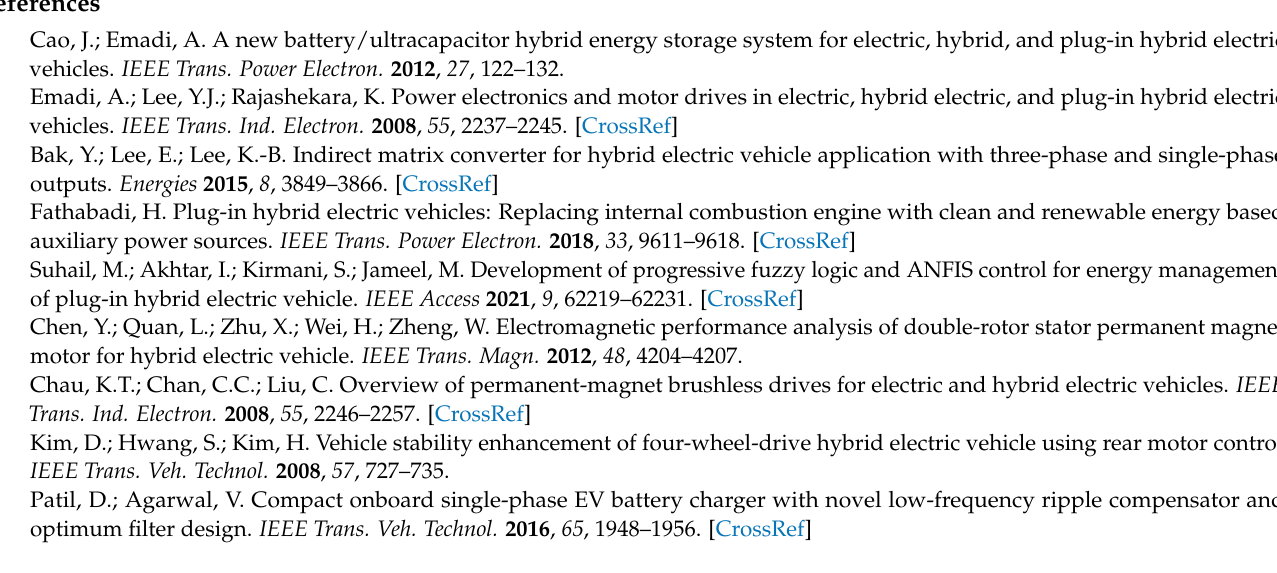
Figure 16. Experimental results of output voltage control of integrated OBC when the load impedance is abruptly changed ( a ) without a feedforward component of output power and ( b ) with a feedforward component of output